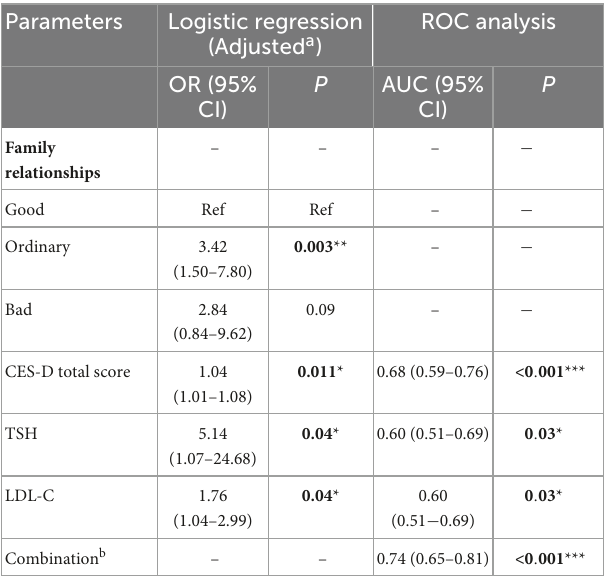
TABLE 3 Adjusted odds ratio (OR) for factors associated with suicide attempts and receiver operating characteristic (ROC) curve analysis results.